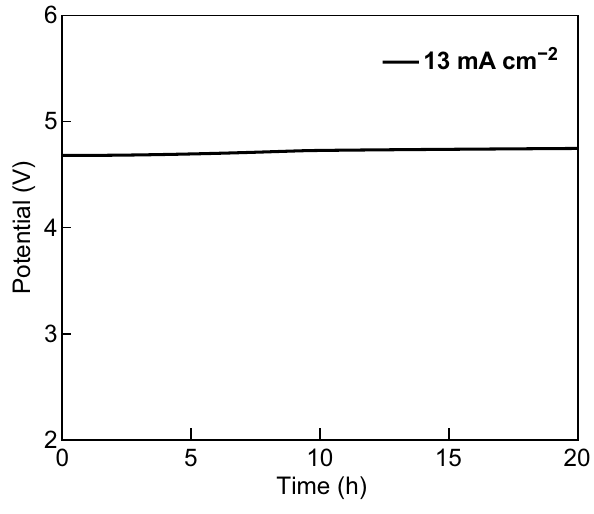
Fig. 6 Chronopotentiometric curve of water electrolysis using large‑ sized NiO/NiNDs@NF‖NiO/NiNDs@NF ( S ~ 70 cm 2 ) with a con‑ stant current density of 13 mA cm